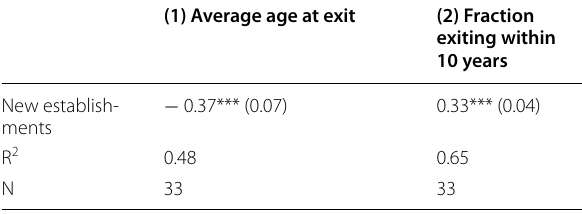
Bivariate regression of the logarithm of the average age at exit of exiting establishments (column 1) and of the logarithm of the fraction of new establishments exiting within 10 years (column 2) on the number of new establishments per birth cohort. Birth cohorts from 1976 to 2008 included. Standard errors in parentheses. */**/*** indicates statistical significance at the 10/5/1 percent level